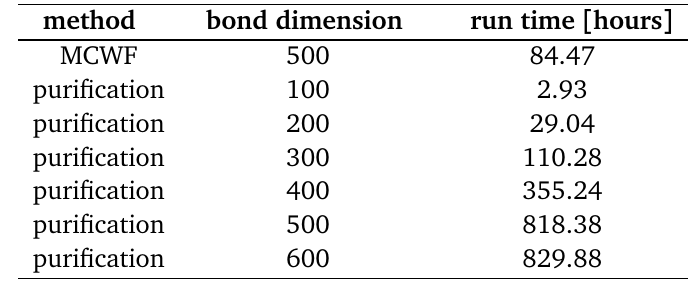
Table 1: Table of run times for evaluating equal-time correlation functions from Fig. 18. The MCWF simulation was executed in parallel on 10 cores. Parameters are the same as in Fig.